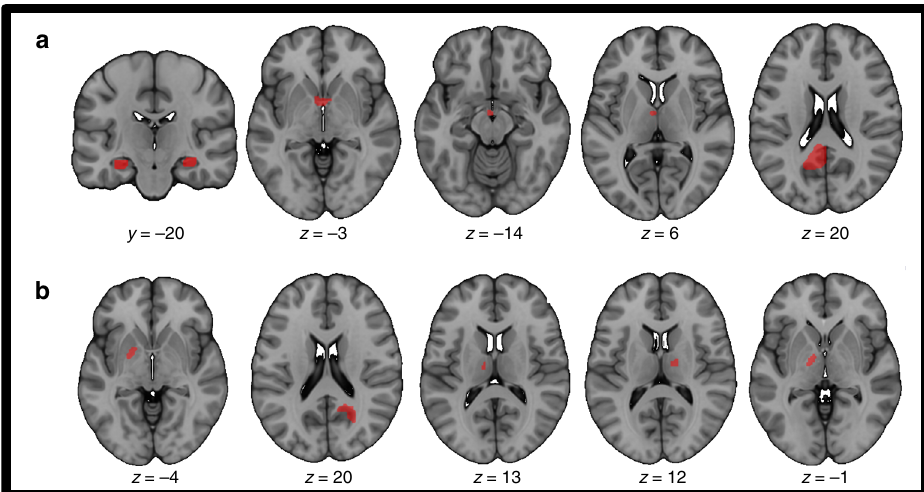
Fig. 1 Ten examples of lesions causing amnesia (from total sample of 53). Lesions causing amnesia include lesions within the classic circuit of Papez ( a ) and lesions outside the classic circuit of Papez ( b